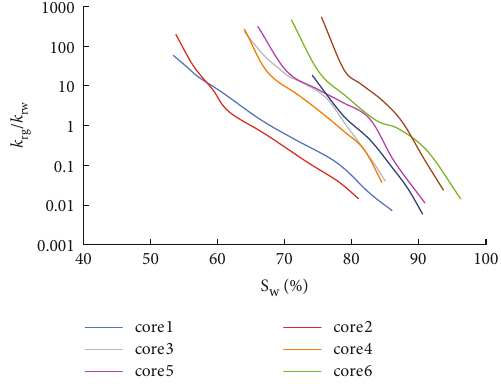
Figure 8: Relationship between k di ff erent